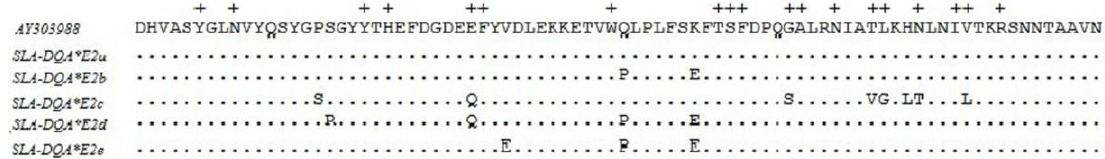
Figure 3. Alignment of the SLA-DQA exon 2 allele amino acid sequences refer to the sequence AY30398. Putative antigen-binding sites (ABS) are marked with plus which have been defined according to Brown et al.